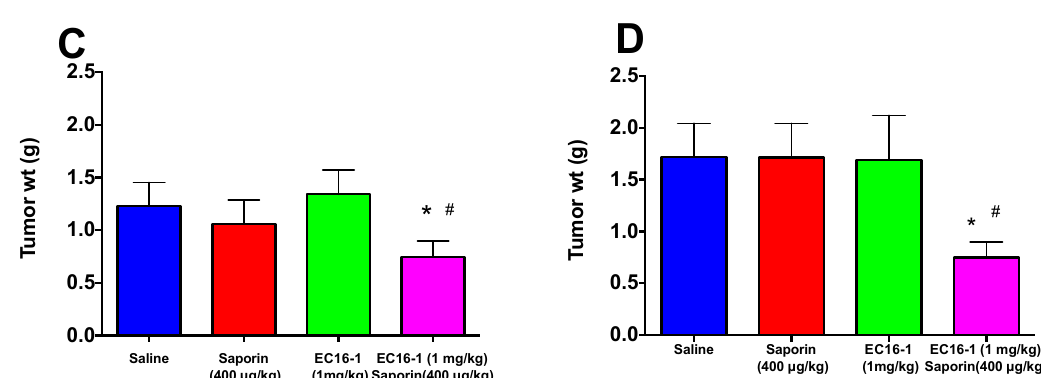
Figure 7. Effect of EC16-1/saporin on the tumor volume and weight of NCI-H460 and NCI-H460/MX20 tumors. The changes in tumor volume over time in NCI-H460 ( A ) and NCI-H460/MX20 ( B ) xenografts following tumor implantation. Each point on the line graph represents the mean tumor volume (mm 3 ) on each day after implantation. The mean weight ( n = 6) of the excised NCI-H460 ( C ) and NCI-H460/MX20 ( D ) tumors from the mice treated with saline, saporin, EC16-1, and EC16-1/saporin, at the end of the 12-day treatment period. The error bars represent the SD. * p < 0.05, compared to the saporin alone group. # p < 0.05, compared with the control group.